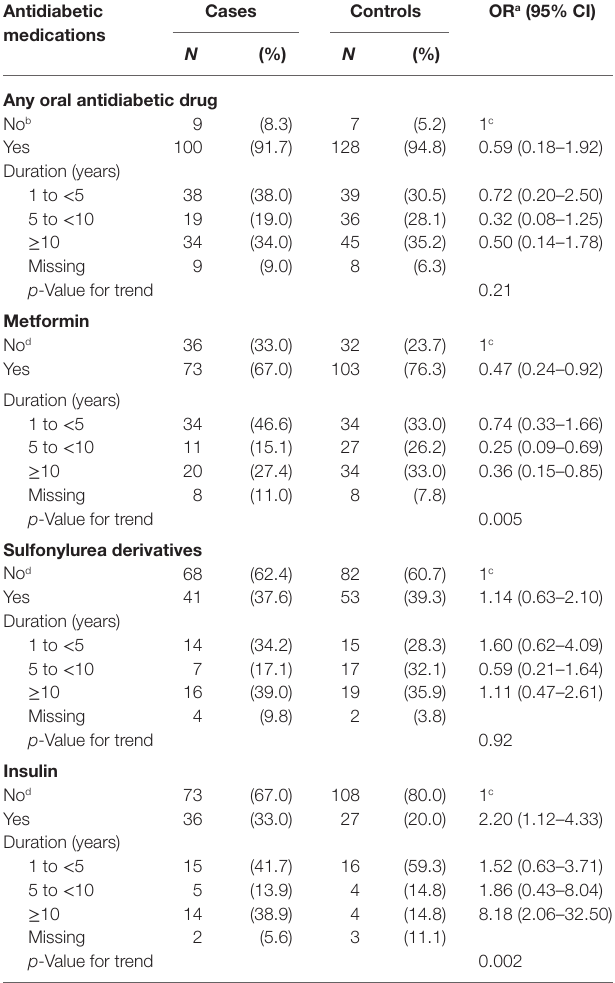
TaBle 4 | Distribution of 109 diabetic colorectal cancer cases and 135 diabetic controls, with corresponding odds ratios (Ors) and 95% confidence intervals (cis), according to use of antidiabetic medications. antidiabetic